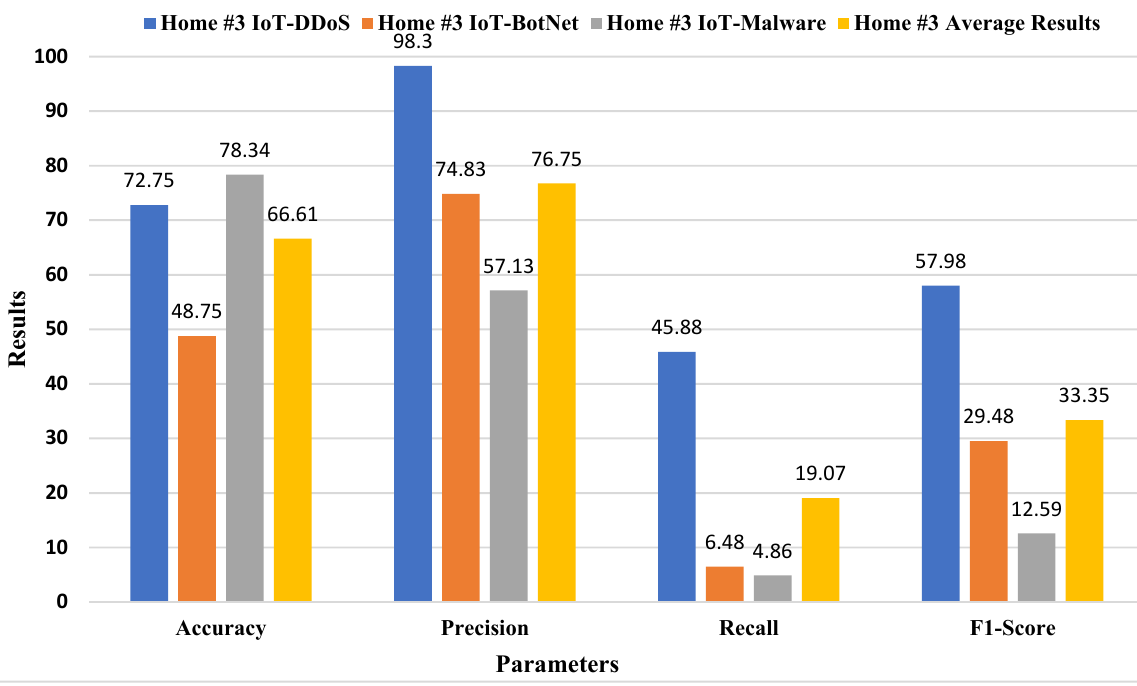
Figure 13. Home #3 dataset